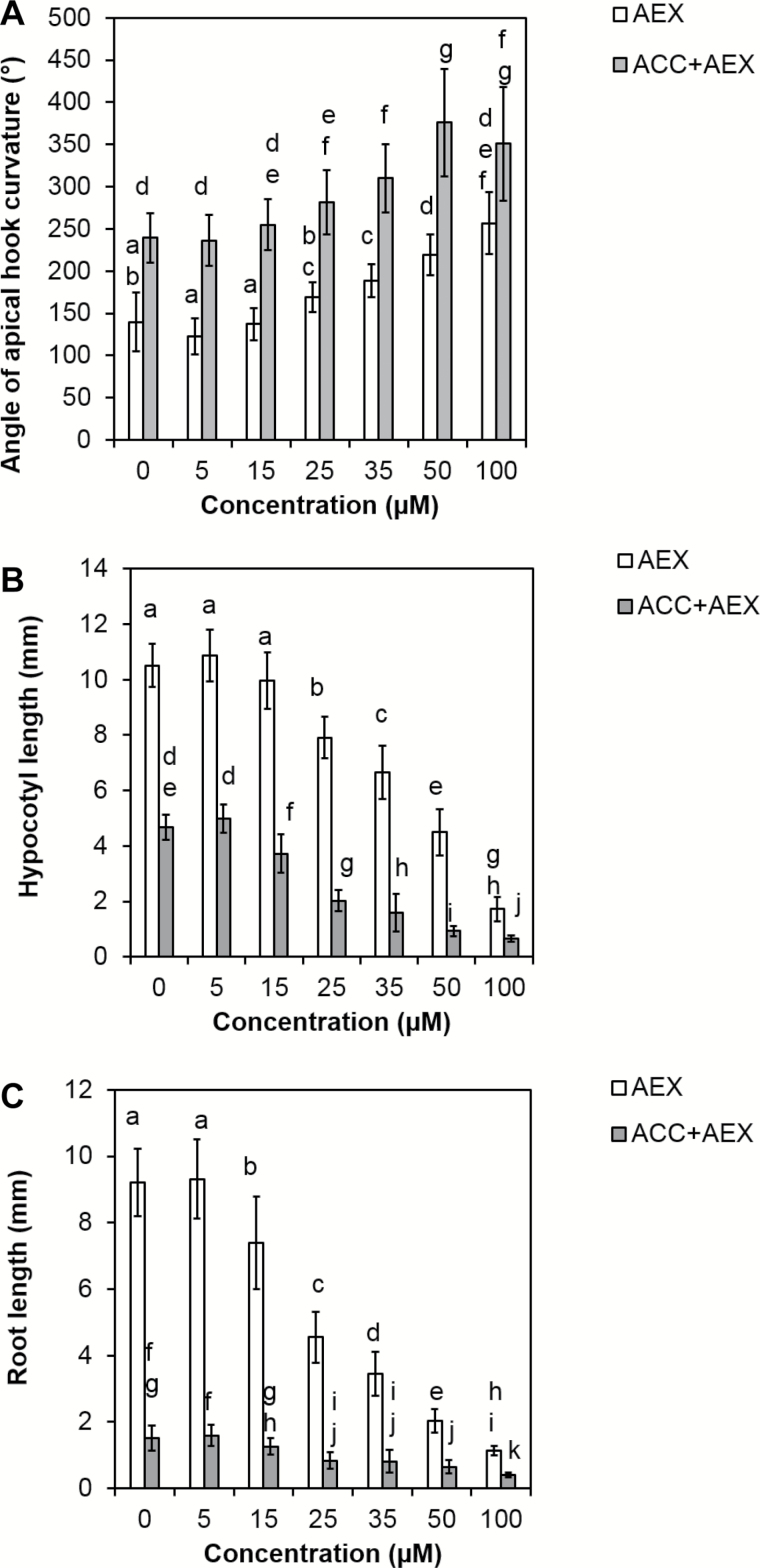
Dose–response of 4-day-old etiolated seedlings exposed to AEX concentrations ranging from 0 to 100 µM, grown on horizontal plates. The apical hook angle (A), hypocotyl (B) and root (C) lengths were measured. White bars represent dose–response effects of AEX alone (at 0 µM AEX, growth medium is supplied with 0.05% DMSO); grey bars represent AEX dose–response effects in the presence of 10 µM ACC. Data are presented as means±SD. Statistical analysis was performed by means of the Scheirer–Ray–Hare extension of the non-parametric Kruskal–Wallis rank sum test. The dependent variables (rank-transformed) apical hook curvature (11>n>30; A), hypocotyl length (10>n>52; B) and root length (10>n>52; C) were compared among treatments and different concentrations (categorical variables). Multiple pairwise comparisons were performed with post hoc Wilcoxon’s rank sum tests (P<0.05) and P-values were adjusted with the Bonferroni correction. Bars with at least one letter in common are not significantly different.